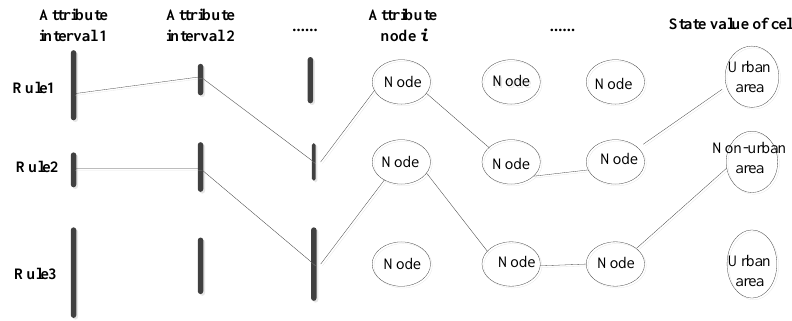
Figure 1. Schematic diagram of interval model based on cellular automata (CA) [35].